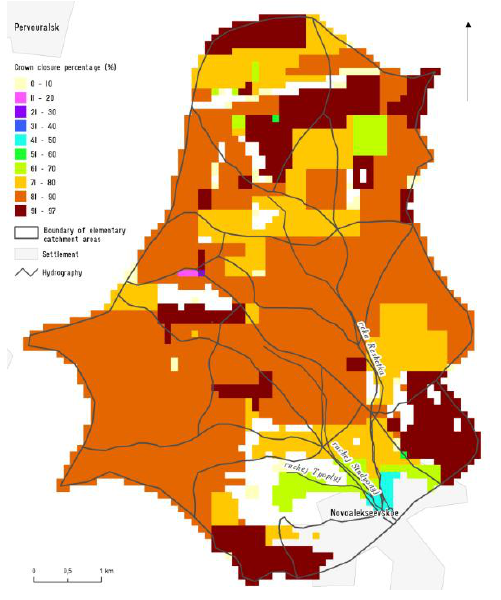
Figure 7. Map of canopy cover .